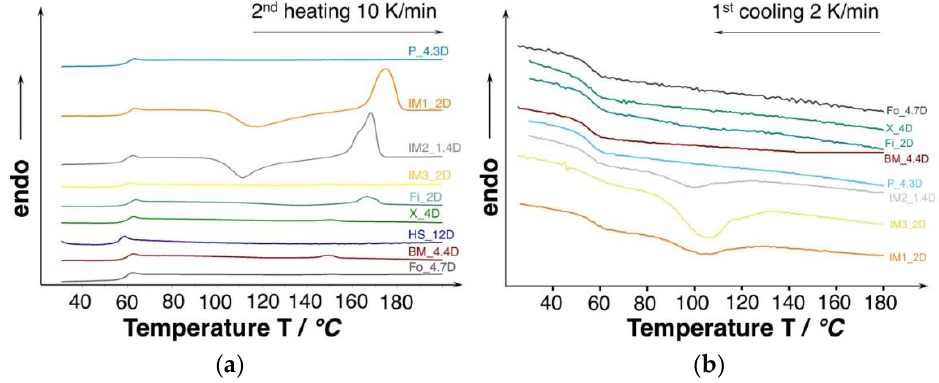
Figure 5. ( a ) Differential scanning calorimetry (DSC) curves of unprocessed PLA (10 K/min., 2 nd heating). ( b ) Cooling curves of the unprocessed PLA with very low cooling rate to favor crystallization (2